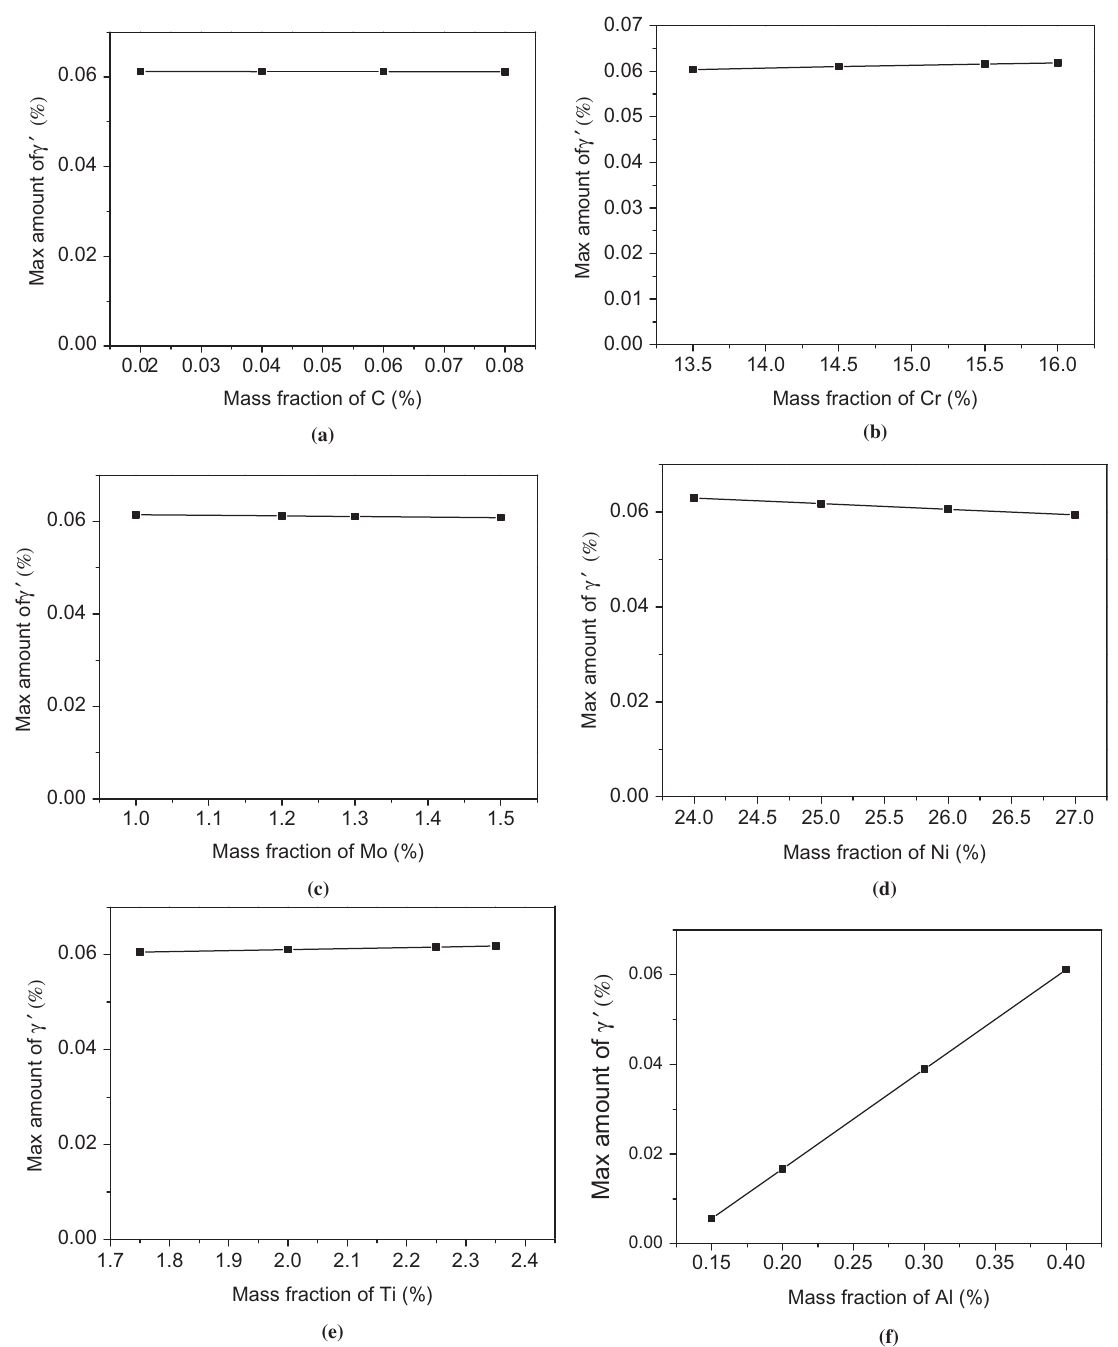
Figure 4: The variation of maximum precipitation amounts of γ ′ phases with the contents of (a) C; (b) Cr; (c) Mo; (d) Ni; (e) Ti; (f)